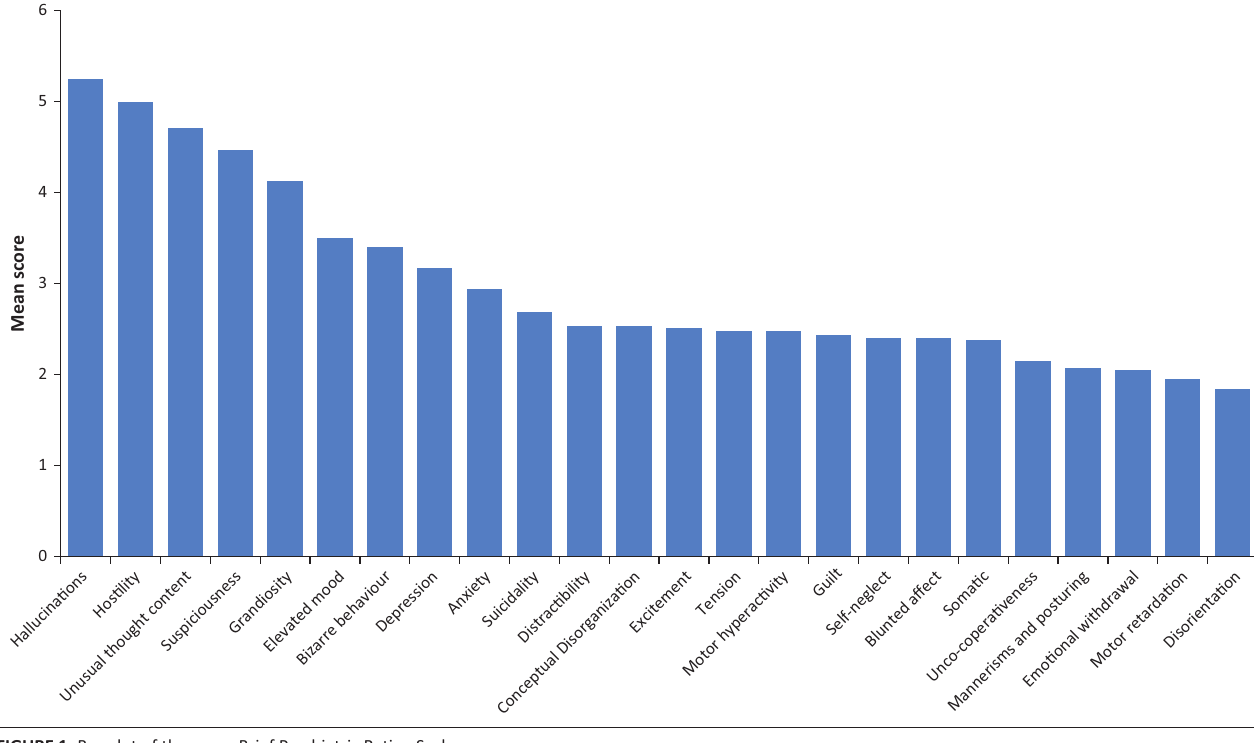
FIGURE 1: Bar plot of the mean Brief Psychiatric Rating Scale